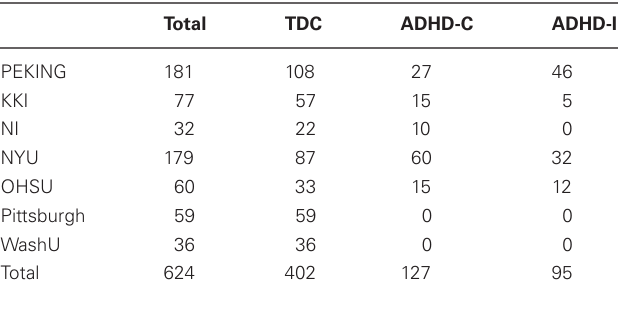
Table 1 | Subjects selected from different sites.